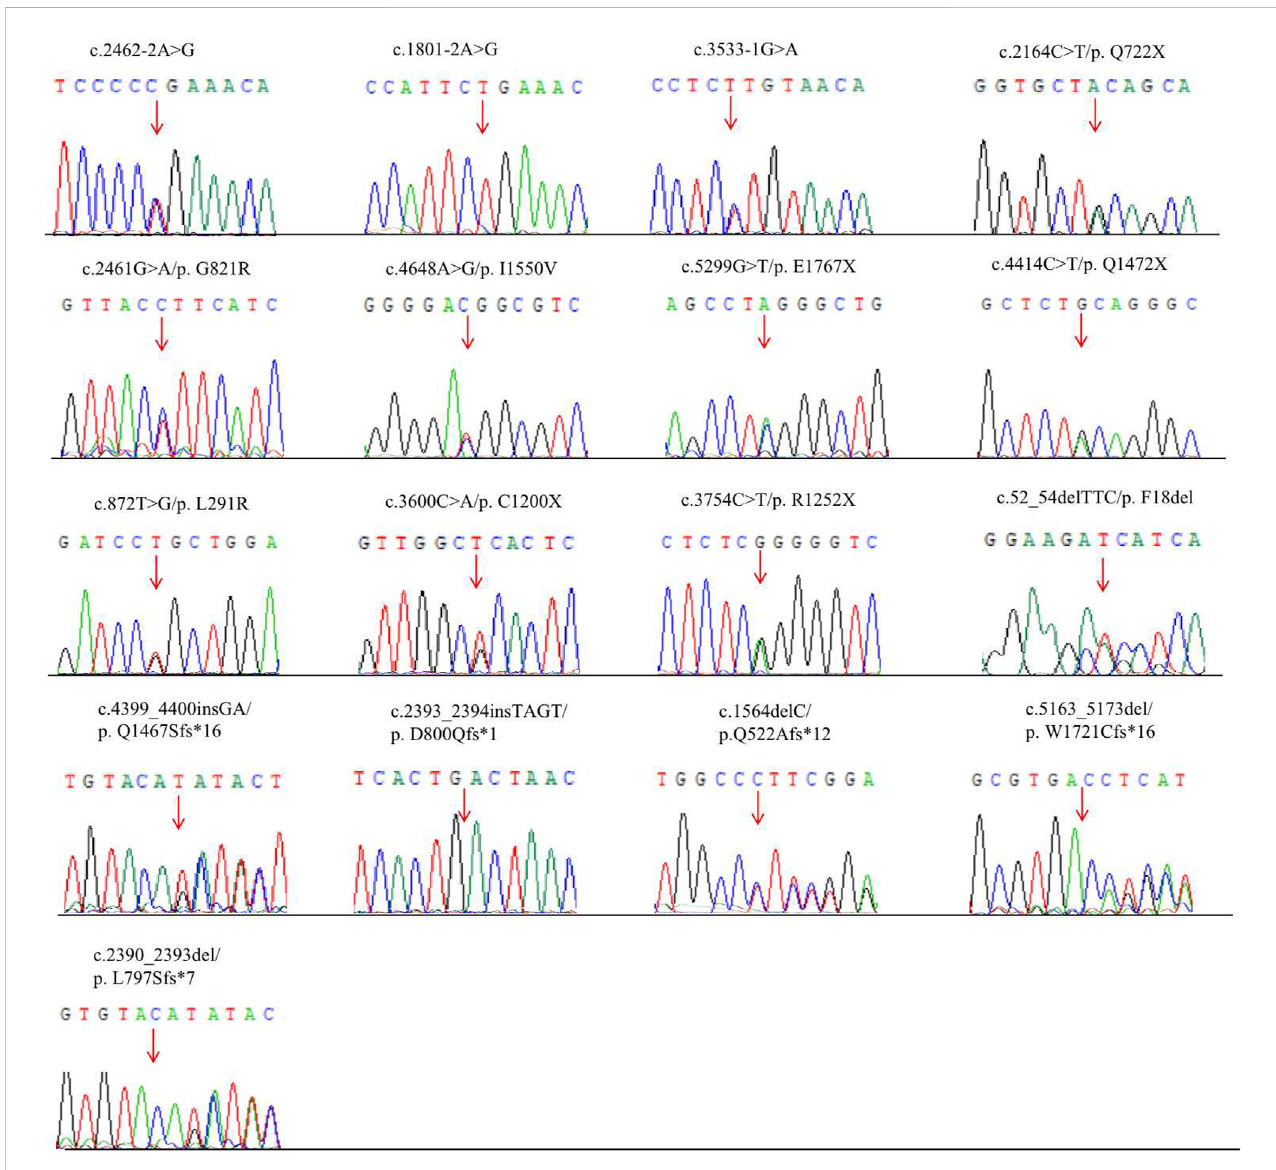
FIGURE 1 Novel mutations of the ANK1 gene identi fi ed in HS patients. Mutation sites are labeled by